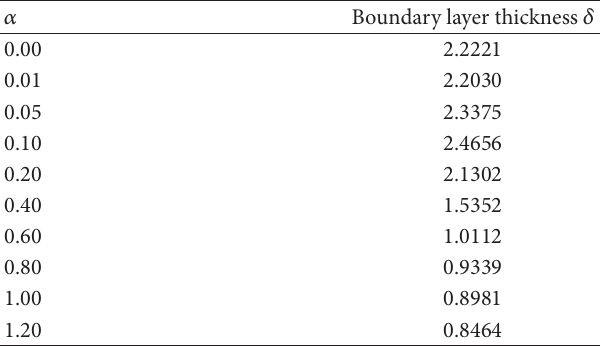
Figure 5: Effect of the parameter 𝜆 on the velocity profile when 𝛼 = 0.1, 𝜉 = 0.5 , and 𝛽 = 5 are kept fixed. Table 2: Effect of viscoelastic parameter 𝛼 on the boundary layer thickness 𝛿 , when 𝜆 = 0.2 , 𝛽 = 5 and 𝜉 = 0.5